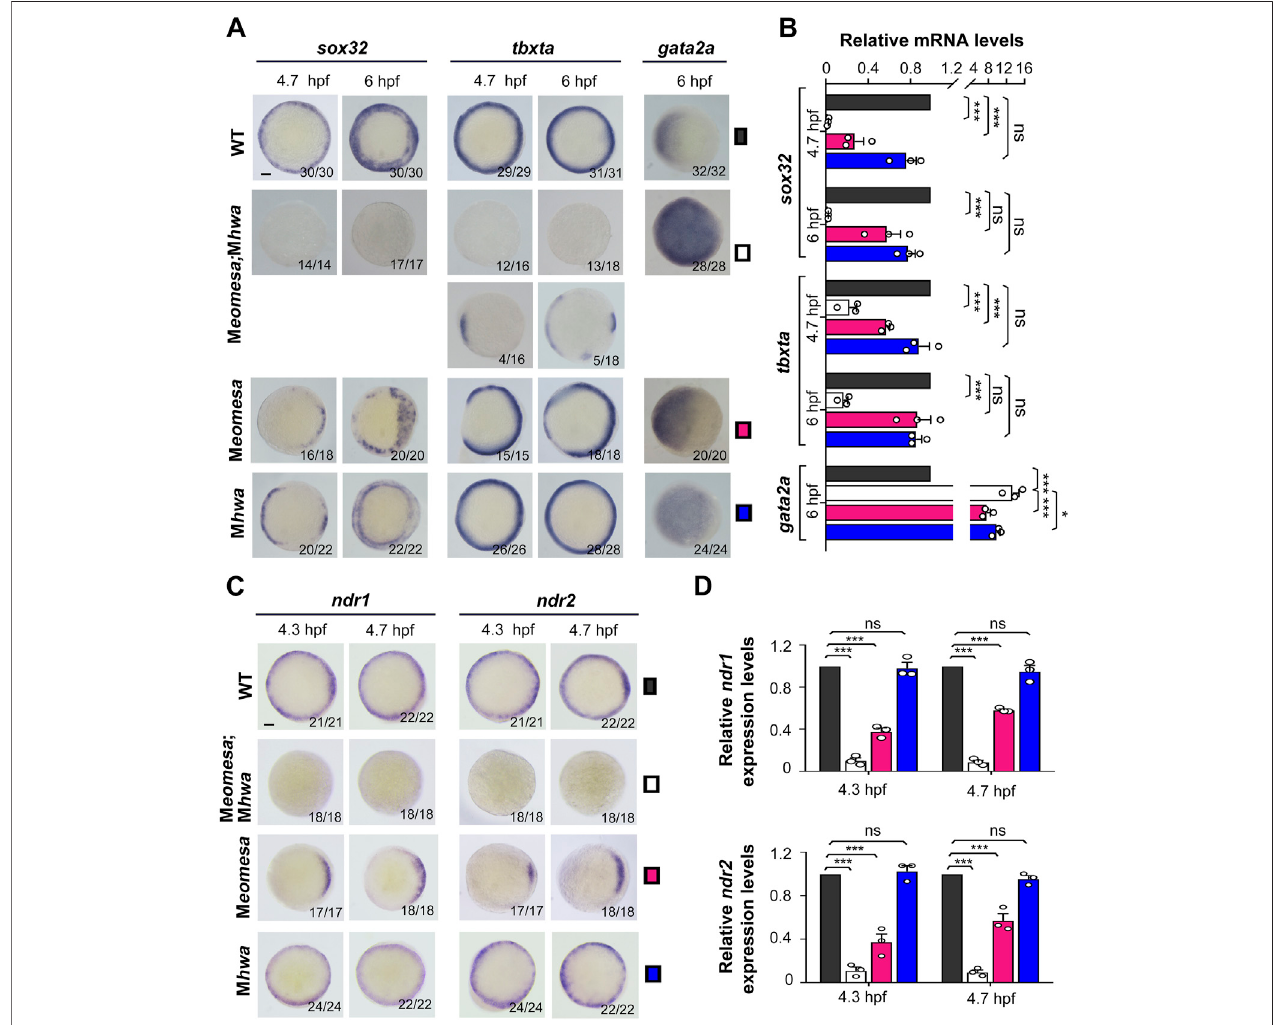
FIGURE 2 | Expression patterns of mesendodermal markers and nodal genes in WT and mutant embryos. The expression of the endodermal marker sox32 , the mesodermal marker tbxta and the epidermal marker gata2a as well as ndr1 and ndr2 was examined by WISH (A,C) or qRT-PCR (B,D) at indicated stages. Embryos in (A,C) wereshowninanimal-poleviewwithdorsaltotherightifthedorsalwasrecognizable.Theratioofembryoswiththerepresentativepatternwasindicatedattheright bottom. Note that the majority of M eomesa ;M hwa embryos completely lacked tbxta expression while the other had some tbxta expression. Scale bars: 100 μ m. For RT-PCR analysis, 15 embryos were pooled for each assay, and the expression level was normalized to that of eif4g2a in WT embryos at the same stage . Error bars indicated S.D. based on three biological replicates (indicated by small circles). Color keys for embryo types were shown in (A,C) . Statistically signi fi cant levels: ns, nonsigni fi cant; **, p < 0.01; ***, p < 0.001.